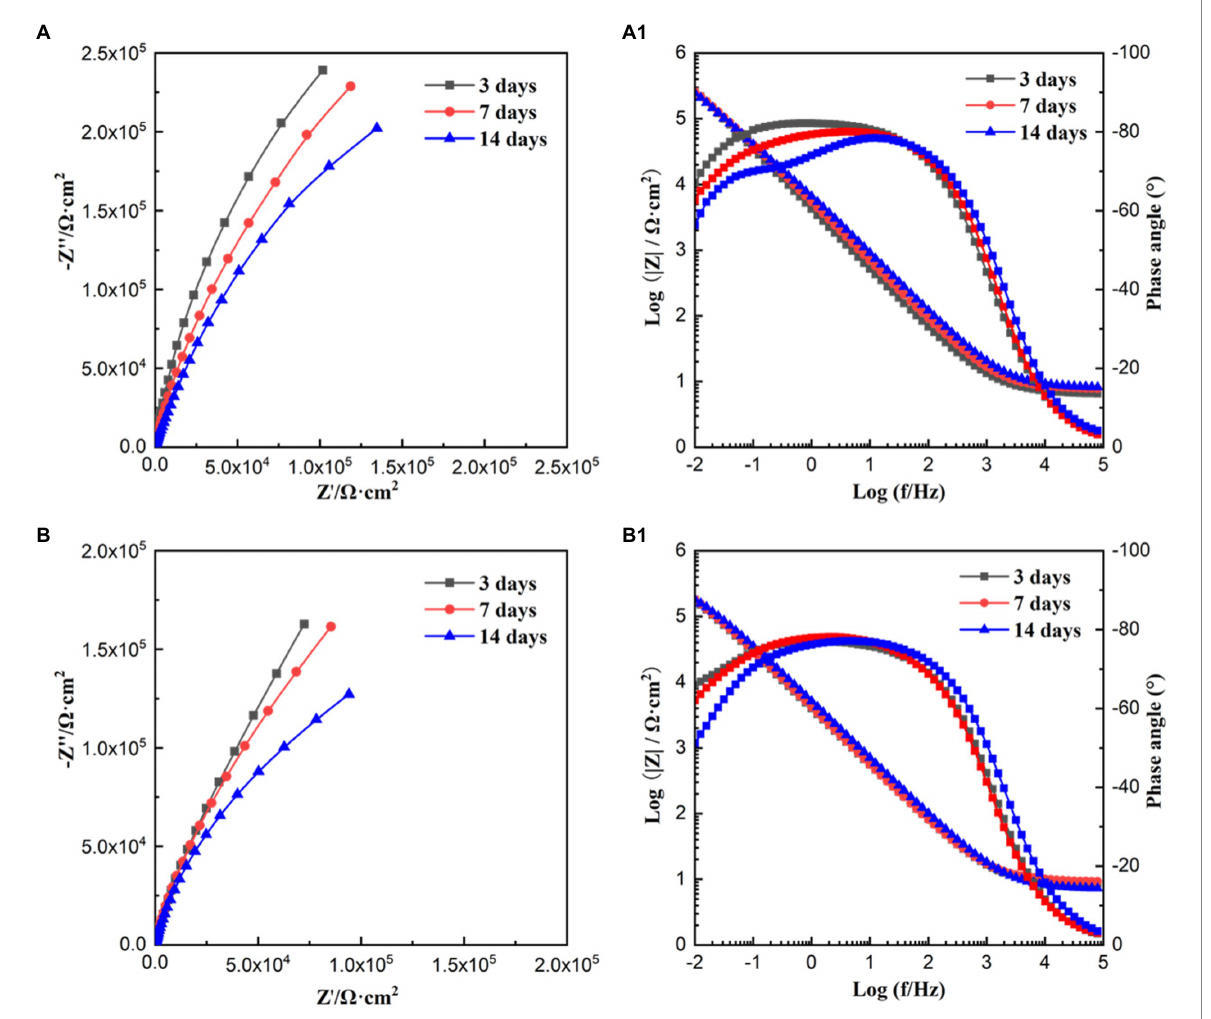
FIGURE 5 Nyquist and Bode plots obtained for HEA coupons in sterile (A,A1) and P. aeruginosa -inoculated medium (B,B1) for 3, 7, and 14 days, respectively.